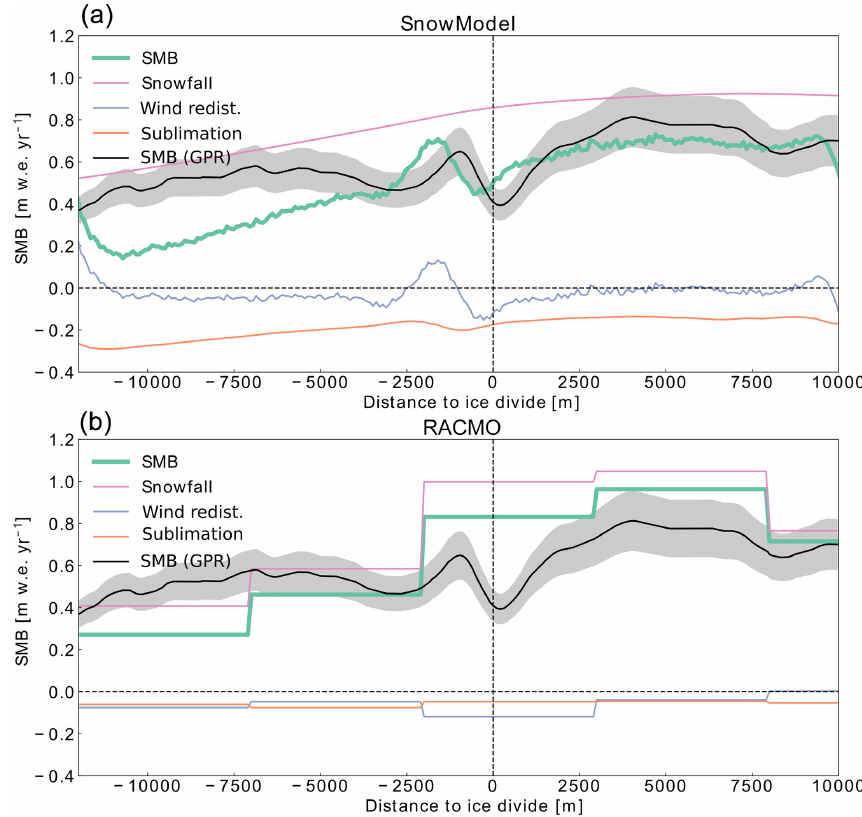
Figure 5. Profiles showing the total SMB and the different components of the SMB across the west-to-east profile of the LIR modeled by (a) SnowModel and (b) RACMO2. SMB reconstructed from the GPR data is also shown together with an estimated error in light gray. The location of the profile is shown in Fig.